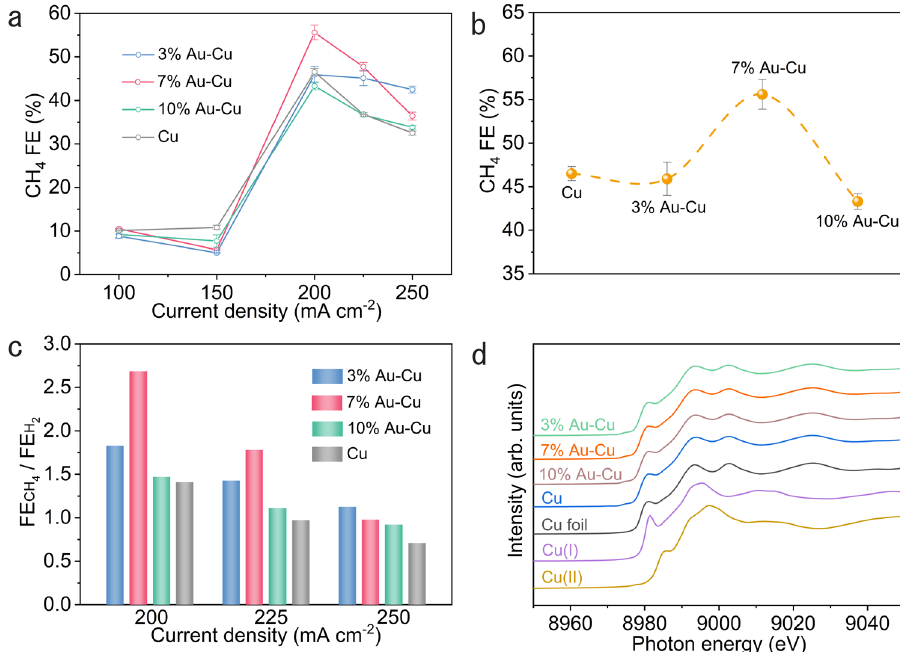
Fig. 4 CO 2 RR performance at 84% CO 2 and operando XAS characterization. a Methane FEs on different catalysts at 84% CO 2 . b Comparison of methane FEs on different catalysts at 200 mA cm − 2 . Error bars represent the standard deviation based on three separate measurements. c Comparison of = FE FE CH H 2 þ ratios on different catalysts at 84% CO 2 . d Operando Cu K-edge XANES spectra of different catalysts during CO 2 RR with a constant current 4 density of 200 mA cm − 2 . Bulk Cu foil, Cu 2 O, and CuO are listed as